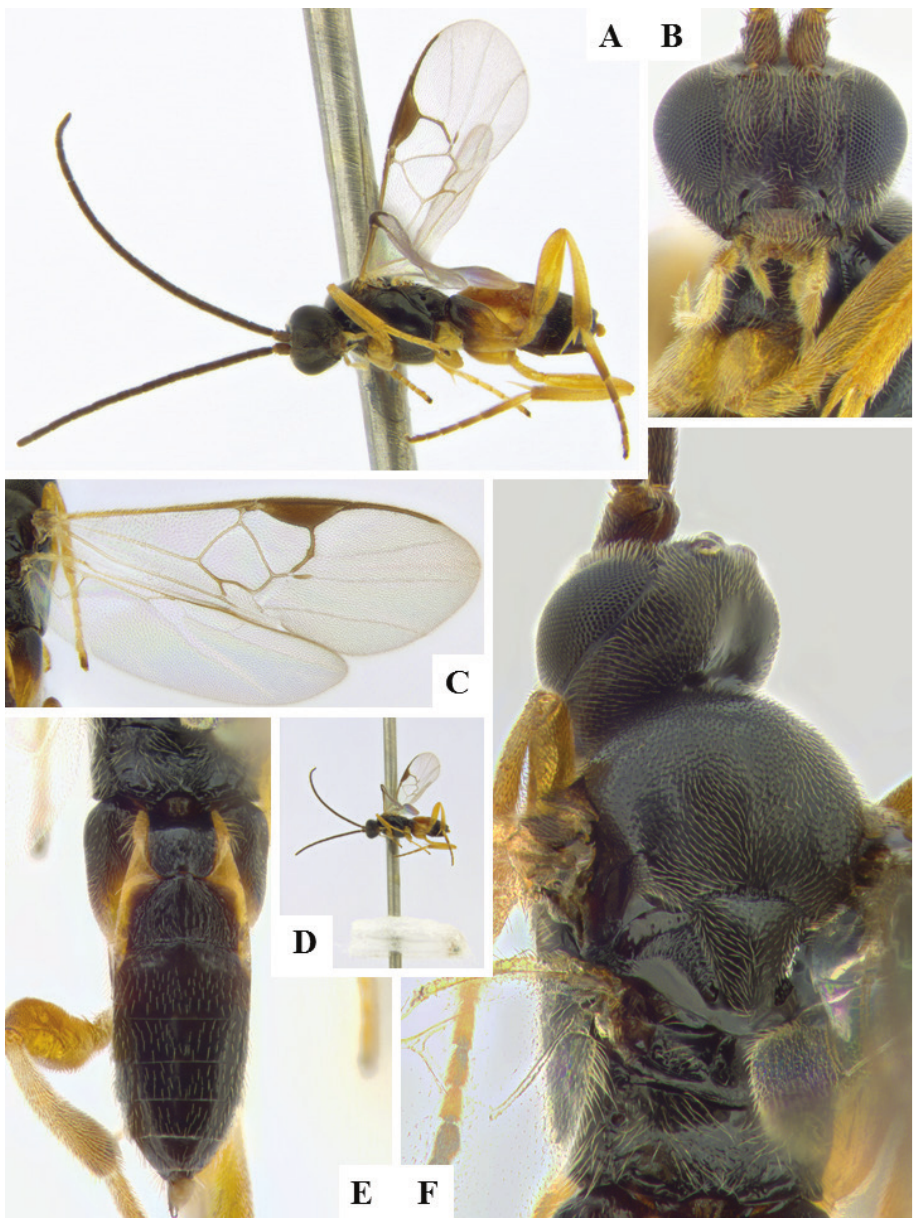
Figure 35. Protapanteles paleacritae. A Habitus, lateral B Head, frontal C Wings D Glued specimen and cocoon E Metasoma, dorsal F Head and mesosoma,